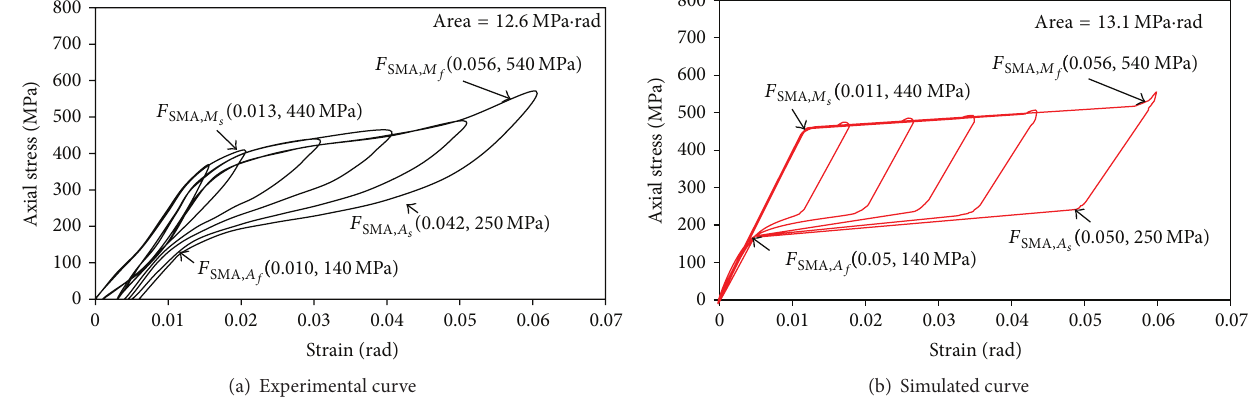
Figure 6: Finite element models.